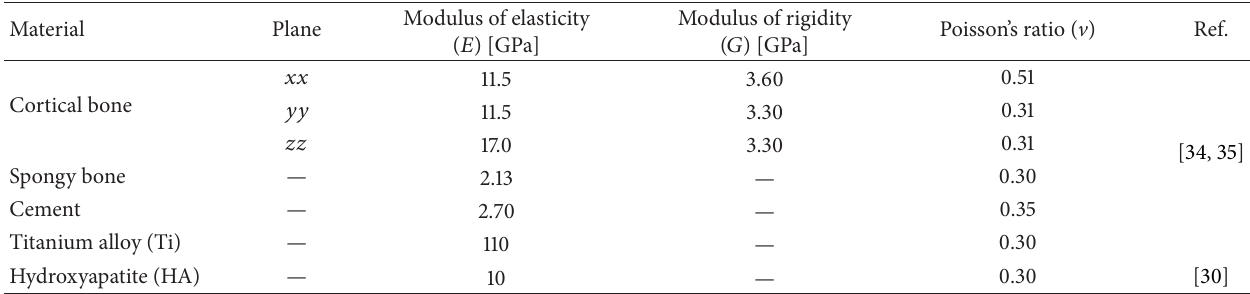
Table 4: Material properties of implanted femur